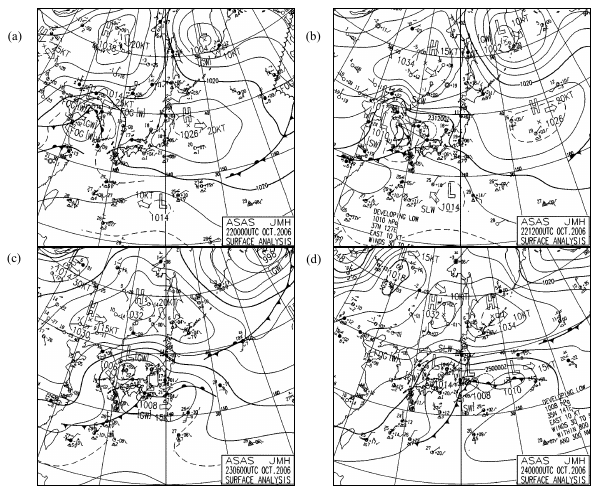
Fig. 19. Weather charts at 00:00 UTC 22, at 12:00 UTC 22, at 06:00 UTC 23 and at 00:00 UTC 24 October 2006 (from JMA). 4